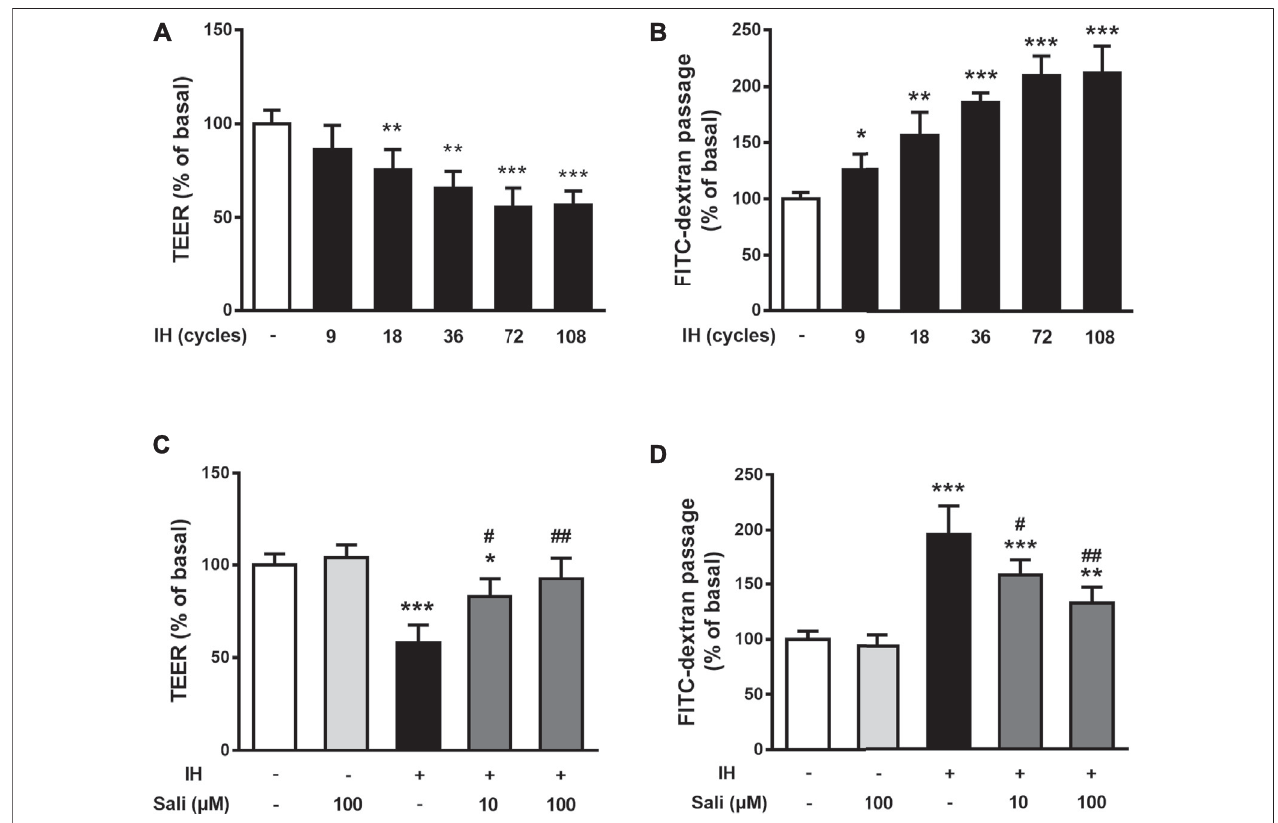
FIGURE2 | Salidroside ameliorated IH-induced endothelial barrier dysfunction in HUVECs. The effects of IH on TEER (A) and permeability to FITC-dextran (B) were determined in HUVECs after 9, 18, 36, 72, 108 cycles of IH exposure. Effects of Sali on TEER (C) and permeability to FITC-dextran (D) were determined in HUVECs pretreated with Sali (10 µM or 100 µM) for 2 h before exposure to either normoxia or 72 cycles of IH. IH, intermittent hypoxia [one cycle includes reducing O 2 for a 20-min hypoxia period (5% O 2 and 5% CO 2 ) followed by 20-min reoxygenation (21% O 2 and 5% CO 2 )]; Sali, salidroside; TEER, transendothelial electricalresistance.Alldataarepresentedasmean ± SD.# p < 0.05and## p < 0.01compared withIHgroup;* p < 0.05,** p < 0.01,and*** p < 0.001compared with normoxia